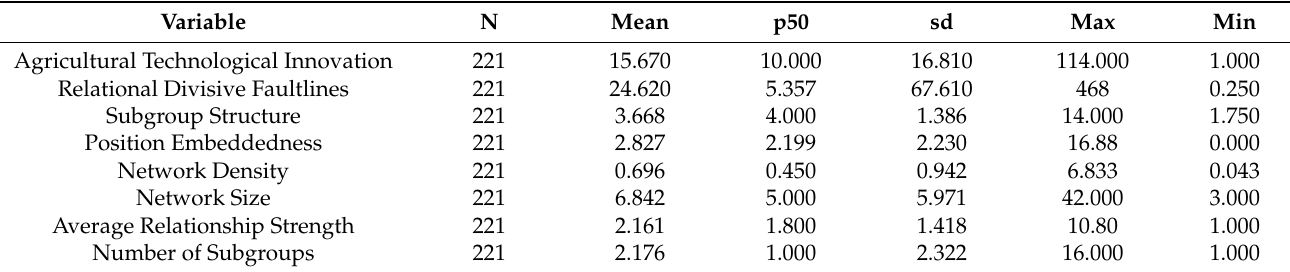
Table 2. Descriptive Statistics of Measured Variables.